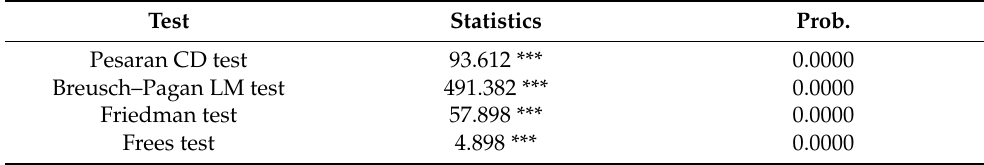
Table 3. Results of the cross-sectional dependence test. Test